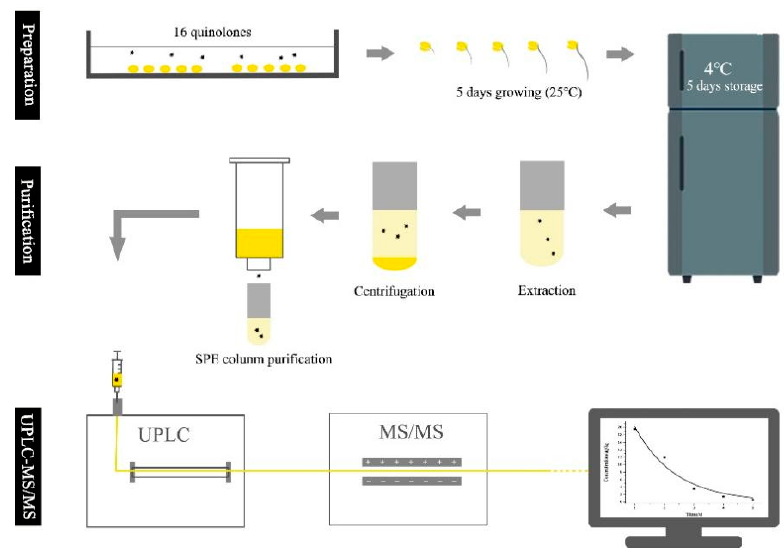
Figure 1. Preparation, purification, UPLC-MS/MS detection of 16 quinolones.